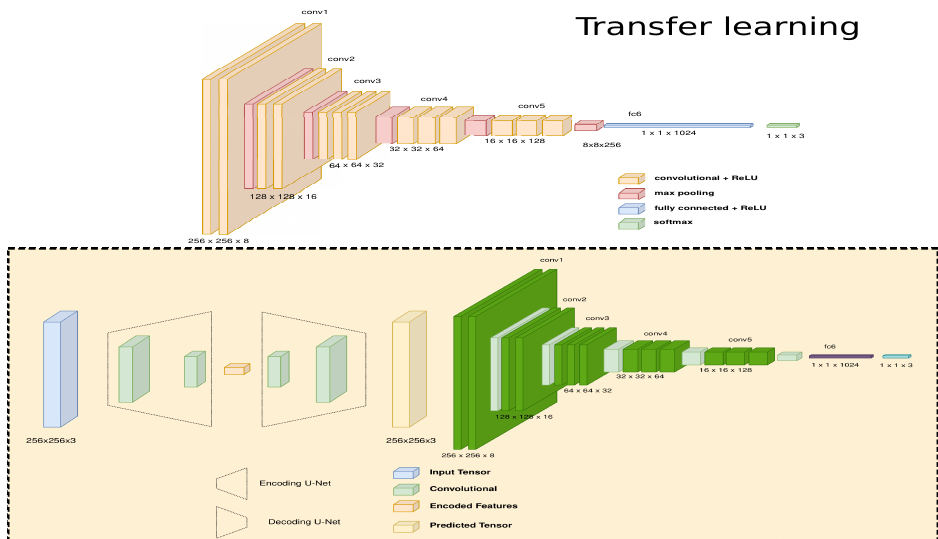
Figure 10. Transfer learning reduces the number of operations since a complex problem with many features is replaced by a model with a smaller number of features.